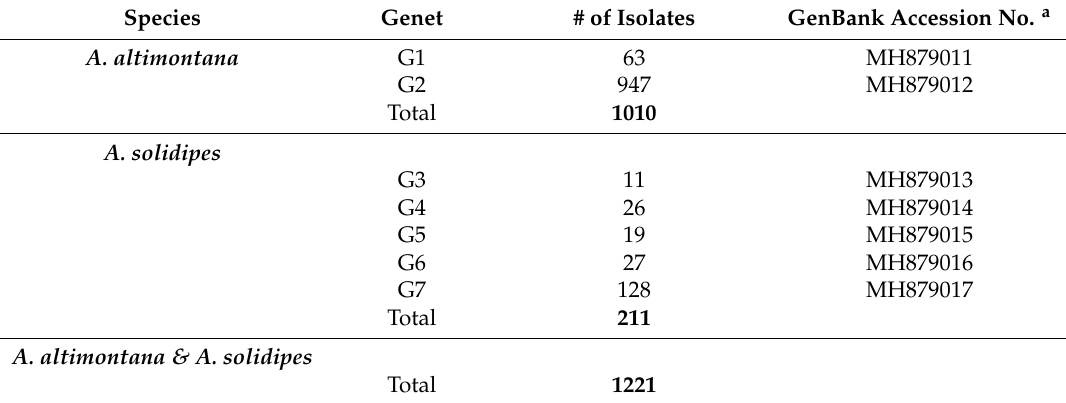
Table 1. The Armillaria isolates, genets, and species collected in 1987 from 2076 western white pine ( Pinus monticola ) planted in a 0.8-ha site at the Priest River Experimental Forest in northern Idaho,